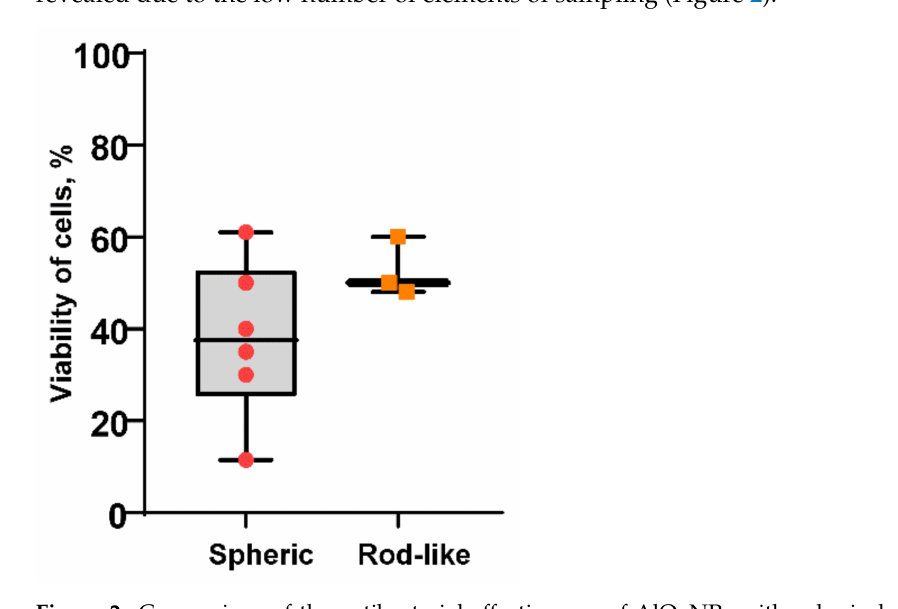
Figure 2. Comparison of the antibacterial effectiveness of AlOxNPs with spherical and rod-like morphology reported in